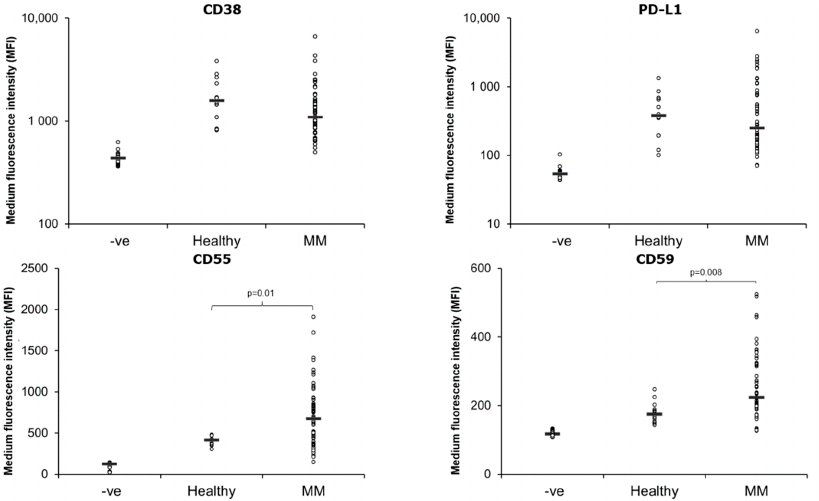
Figure 2. Complement inhibitory proteins CD55 and CD59 are higher on Multiple Myeloma periph- eral blood EVs relative to healthy control PB EVs. 1.25 × 10 7 EVs/test from 61 MM patients and 12 healthy controls were bound to the surface of 4 µ m aldehyde/sulfate latex beads and stained with antibodies for CD38 and PD-L1 and the complement inhibitory proteins CD55 and CD59 for 30 min on ice. The samples were then resuspended in 200 µ L PBS and flow cytometry analysis was performed on a CytoFLEX LX Flow Cytometer. Gating of EV-decorated 4 µ m in diameter beads was performed based on FCS/SSC parameters, so that unbound EVs or possible antibody aggregates are excluded from the analysis.